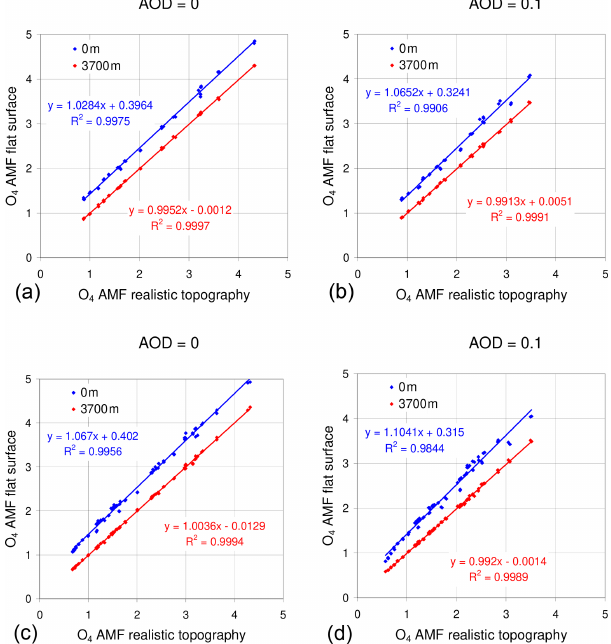
Figure 4. Comparison of simulated O 4 AMFs for different choices of the surface topography. Results for flat surfaces at sea level (blue) or 3700m (red) are plotted versus the results for a realistic surface topography (see Fig. 3). (a, b) Results for winter and (c, d) results for summer. (a, c) Results for simulation without aerosols and (b, d) results for an AOD of